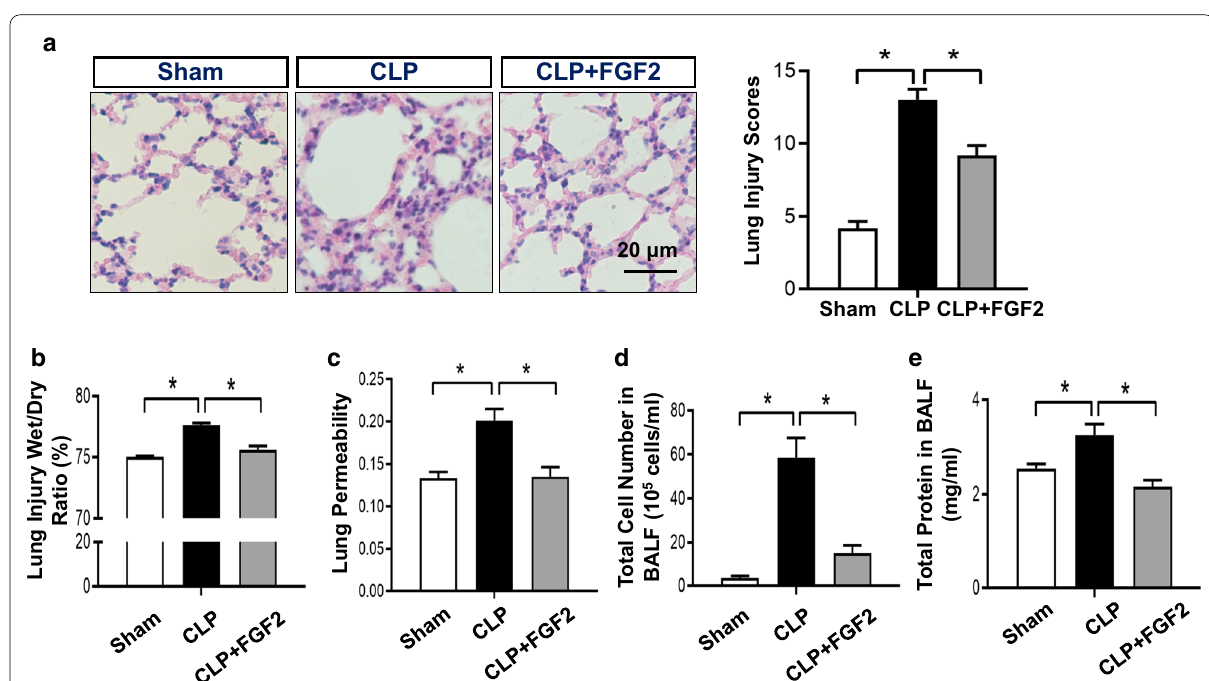
Fig. 2 FGF2 controls the pathology and hyperosmotic state in septic lungs. a The different groups of lung tissue sections were stained by hematoxylin–eosin (H&E) and analyzed by the lung injury scores. b The lung levels of wet/dry weight ratio. The formula: ratio (n 5 per group). c The measurement of Evans Blue permeated into mesenchyme of lung reflecting the permeability of vessel was detected by ≥ microplate reader (n 5 per group). d Total cell numbers in BALF were calculated with hemacytometer (n ≥ BALF was evaluated by the BCA kit (n 5 per group). Data are represented as mean ≥